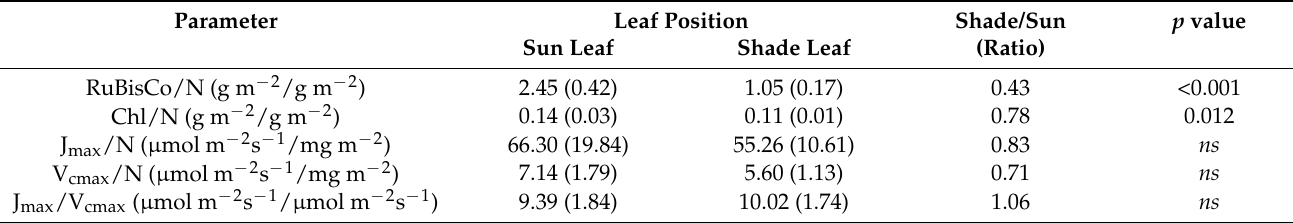
Table 3. RuBisCo/N, Chl/N, V cmax /N, J max /N and J max /V cmax of Robinia pseudoacacia in sun and shade leaves, and relative changes between these leaf positions. Values represent mean (SE in parentheses). The significance of the leaf position is indicated by the p value ( ns = nonsignificant). ANOVA was used to test the difference between the leaf position at the 0.05 alpha level.